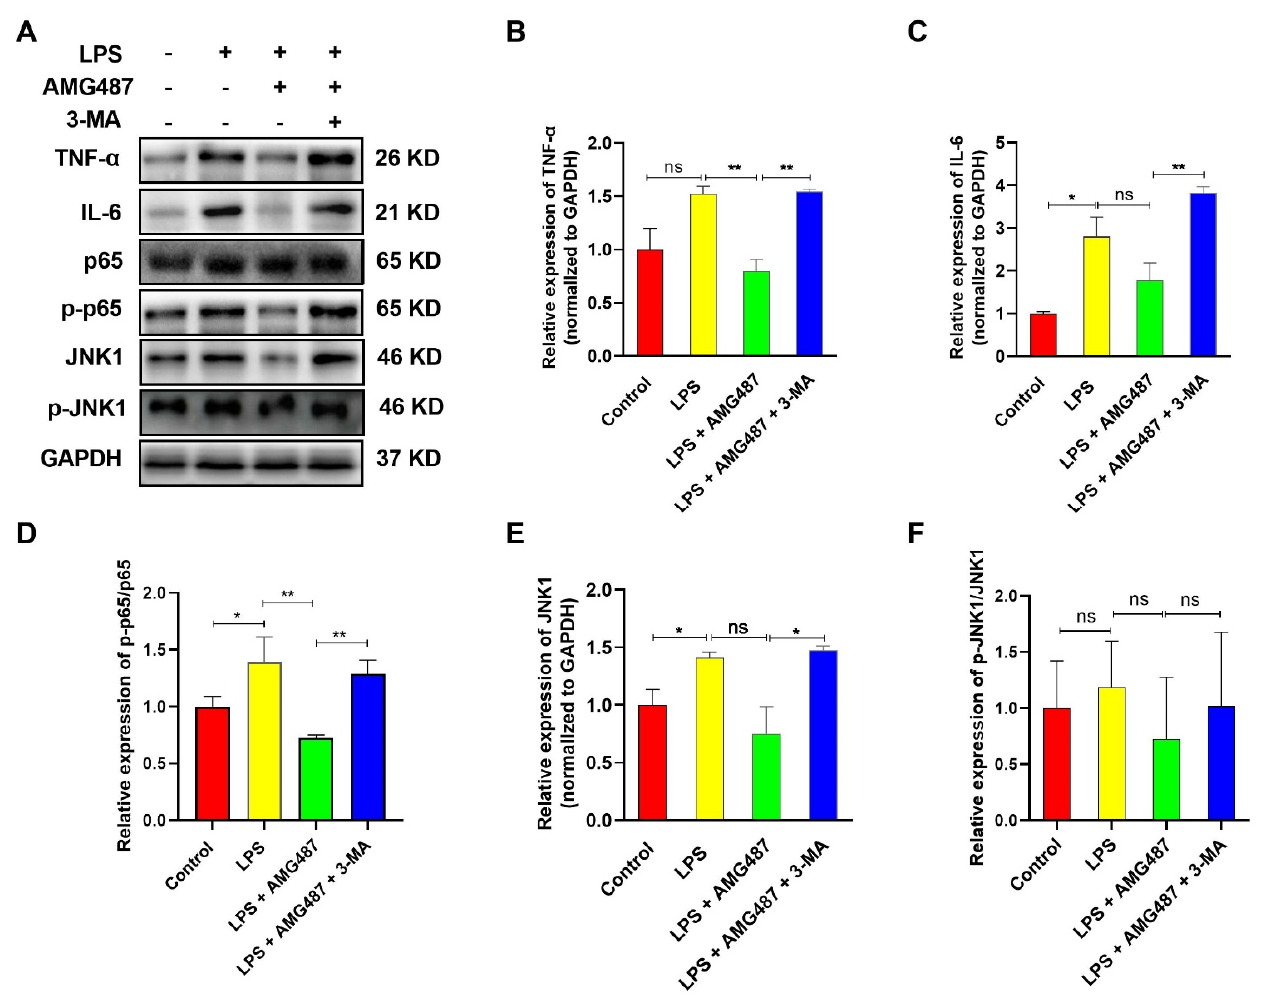
Figure 5. CXCR3 inhibition blocks NF- κ B signaling pathway activation by promoting autophagy in the IPEC-J2 cells. The cells were divided into four groups, namely, the Control group, LPS (10 µ g/mL) group, LPS + AMG487 (1 µ M) group, and LPS + AMG487 + 3-MA (5 mM) group. The cells were treated for 12 h, and the protein was extracted for Western Blot. ( A ) The expression of NF- κ B pathway-related proteins in IPEC-J2 cells. ( A , B ) TNF- α expression. ( A , C ) IL-6 expression. ( A , D ) p-p65/p65 expression. ( A , E ) JNK1 expression. ( A , F ) p-JNK1/JNK1 expression. Image J software analyzed the optical density values of NF- κ B signaling pathway-related proteins. Values represent the mean ± SEM. of three independent experiments. Significant differences are represented by * p < 0.05, ** p < 0.01, and ns (not